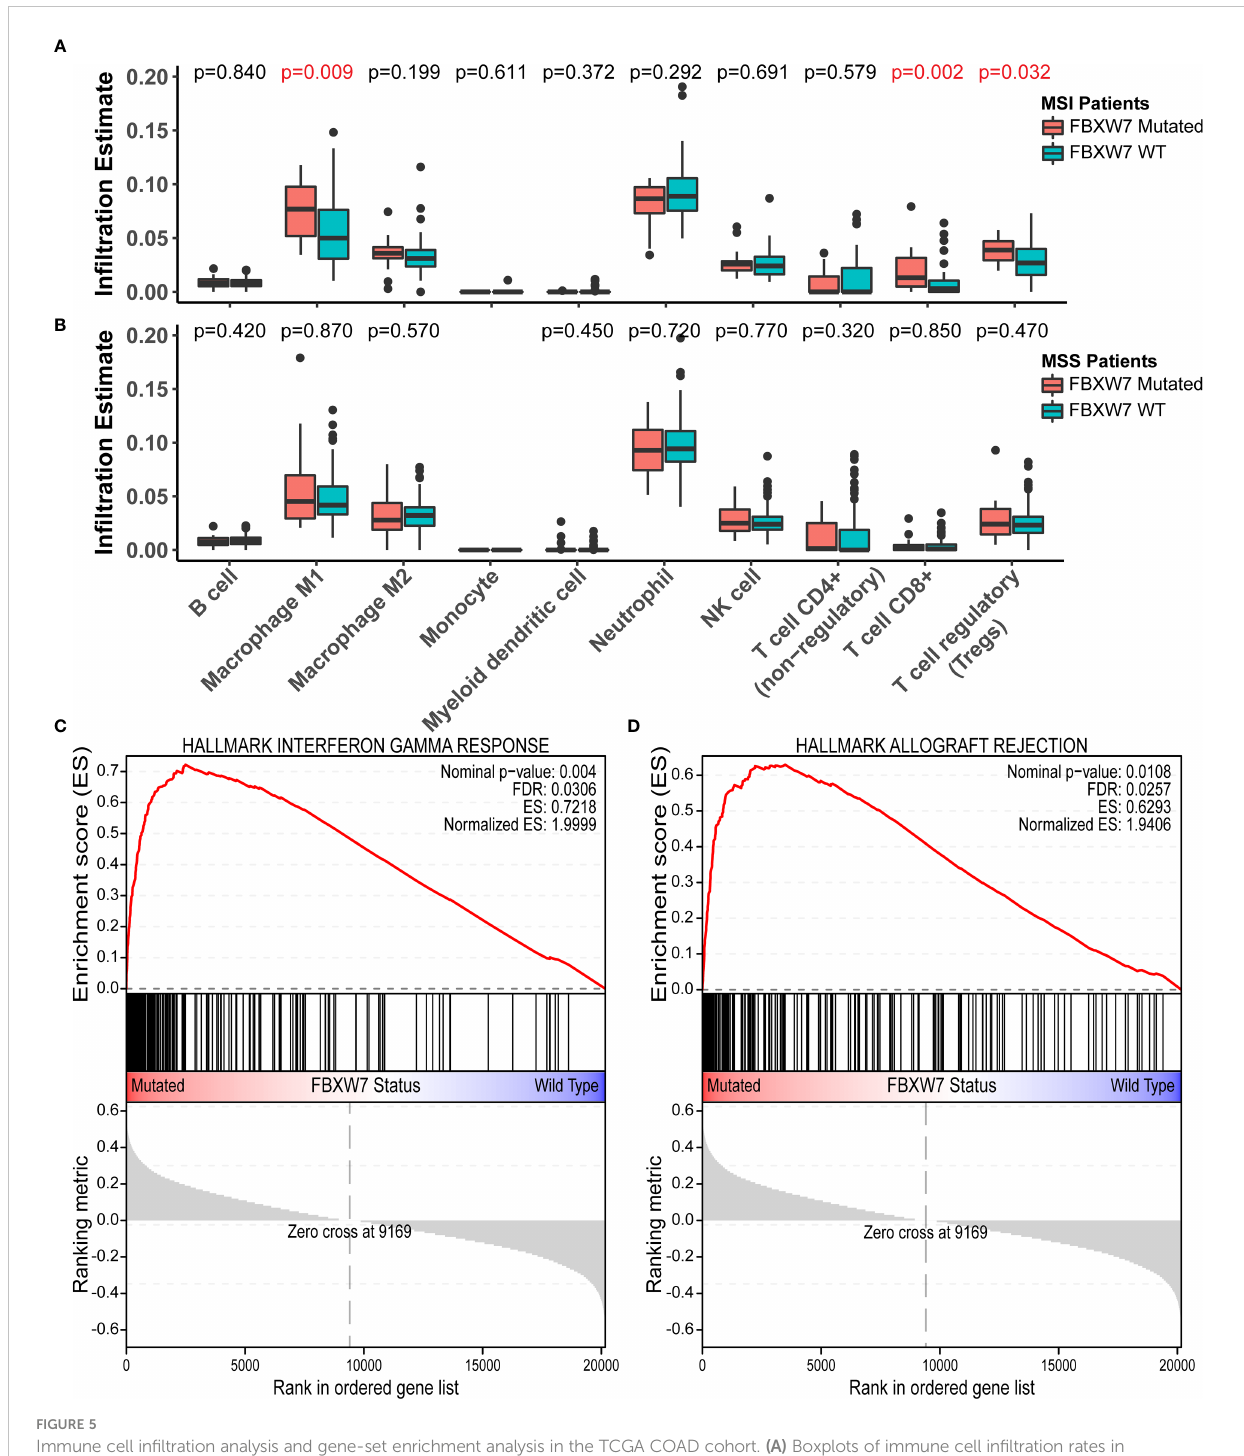
FIGURE 5 Immune cell in fi ltration analysis and gene-set enrichment analysis in the TCGA COAD cohort. (A) Boxplots of immune cell in fi ltration rates in microsatellite instable patients regarding different FBXW7 mutation status; (B) Boxplots of immune cell in fi ltration rates in microsatellite stable patients regarding different FBXW7 mutation status; (C) Hallmark gene set interferon gamma response enrichment plot in TCGA COAD patients regarding FBXW7 mutation status; (D) Hallmark gene set allograft rejection enrichment plot in TCGA COAD patients regarding FBXW7 mutation